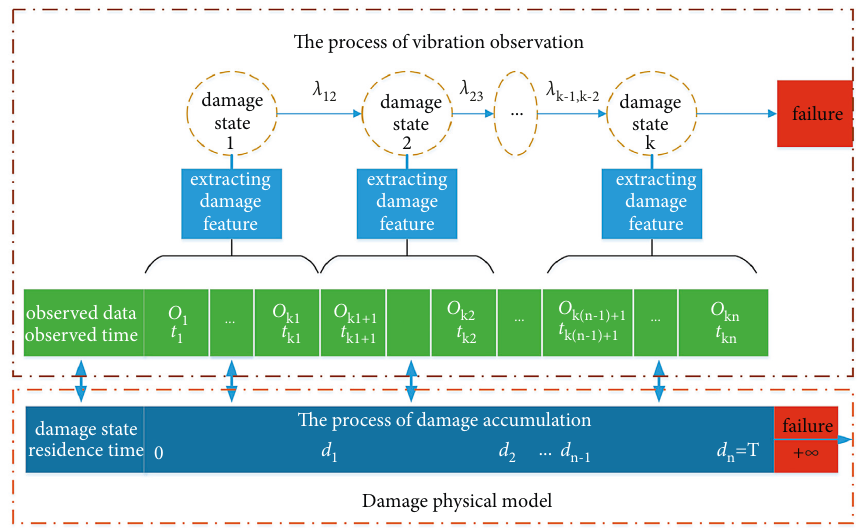
Figure 2: The relationship between the equipment observation process and damage